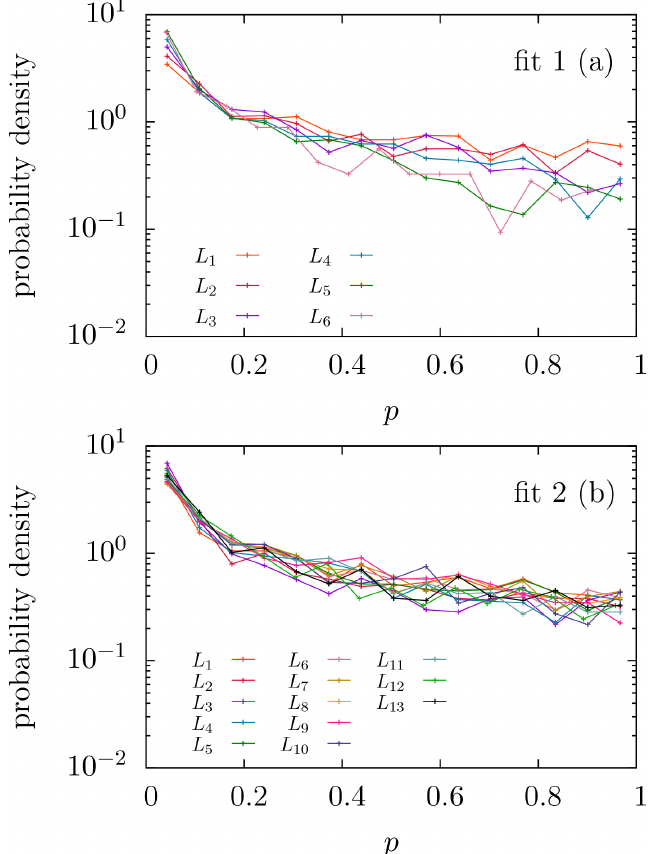
Fig 5. Estimated probability density functions of p -values conditioned to p (cid:2) 0.01 separating for different ranges of text length L . p -values correspond to the fitting of word frequencies to (a) distribution f 1 and (b) distribution f 2 . We divide the distribution of text length into 15 intervals of 2 000 texts each. For distribution f 1 only the first seven groups (up to length 34 400) are displayed (beyond this value we do not have enough statistics to see the distribution of p -values greater than 0.01, as displayed in Fig 6; for distribution 2 this happens only in the last two groups). The intervals L i range from L 1 = [115, 5291] to L 6 = [25739, 34378] and to L 13 = [89476,